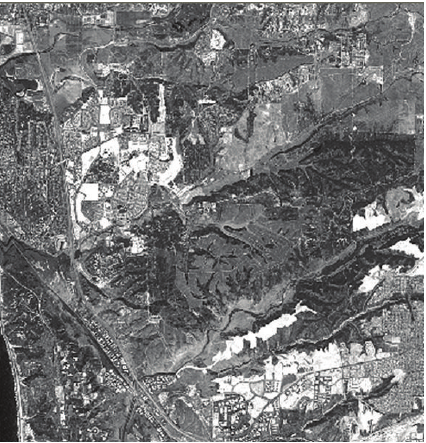
Figure 1: Original TM (multispectral) image.